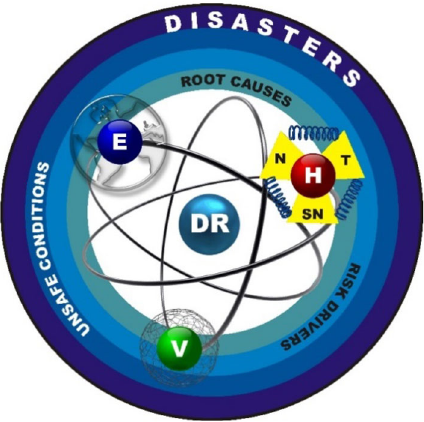
Fig. 1 Key relationships and processes in the social construction of risk. E exposure, V vulnerability, H hazard, with the categories N (natural), T (technological), and SN (socio-natural), DR disaster risk (Oliver-Smith et al.